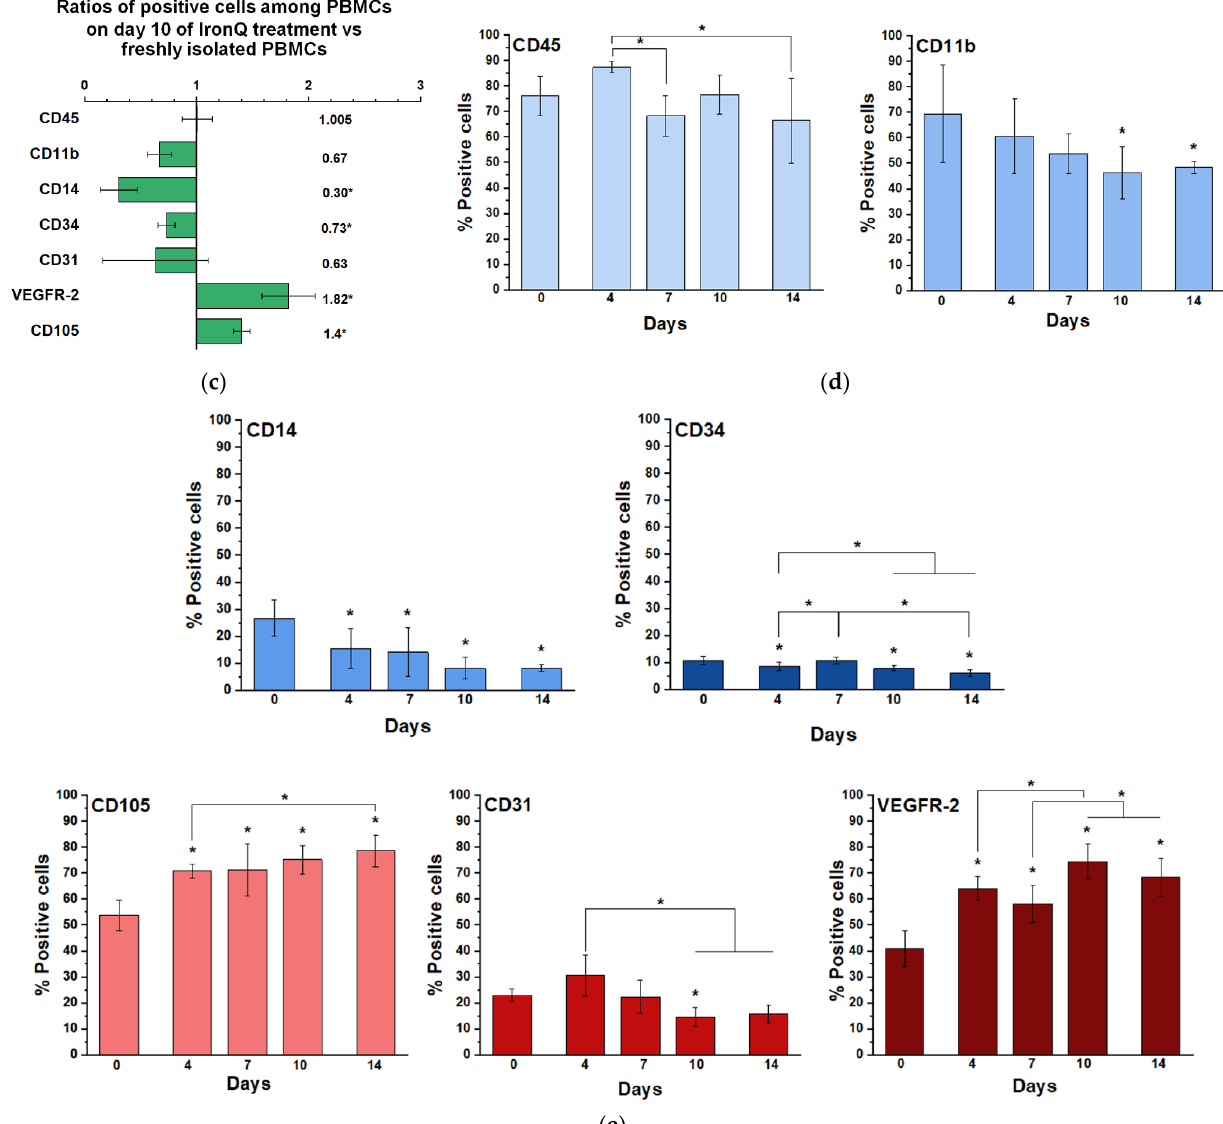
Figure 2. Flow cytometry analysis of pre-and-post IronQ PBMCs. ( a ) Scatter diagrams of pre-and-post IronQ PBMCs in flow cytometry. The red lines indicate the cellular-sized gates of lymphocytes and monocytes (R1), or the larger cells (R2). ( b ) Flow cytometry analysis for stem cells (cluster of differentiation 34 (CD34)), hematopoietic cells (CD14, CD11b, and CD45), and angiogenic (CD105, VEGFR-2, and CD31) markers in post-IronQ PBMCs (at day 10). ( c ) The bar graph shows the ratio of each percentage (%) of cell positivity in post-IronQ PBMCs (at day 10) to that of untreated PBMCs. The column represents the mean ± SD in each increase or decrease ( n = 16), * p < 0.05. ( d,e ) Flow cytometric analysis of kinetic profiles of marker expression across population expansion. The data are presented as the mean ± SD ( n = 8), * p < 0.05. PBMCs: peripheral blood mononuclear cells; IronQ: iron–quercetin complex; VEGFR-2: vascular endothelial growth factor receptor 2.